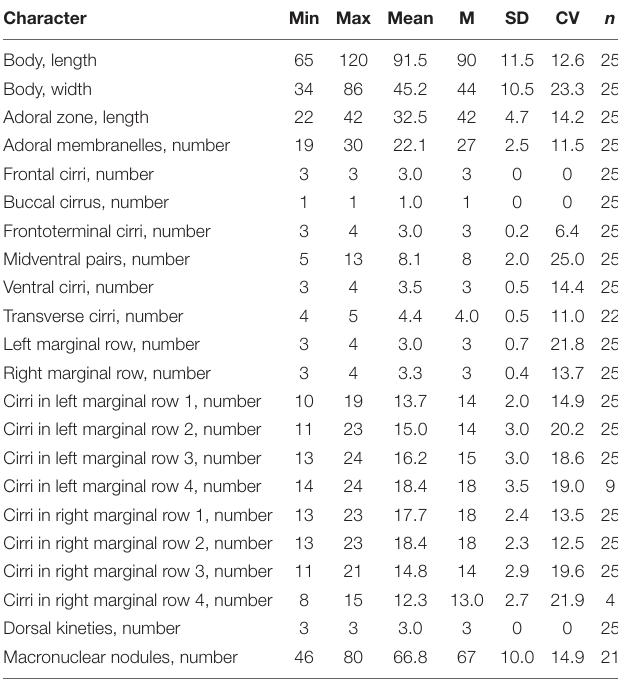
TABLE 1 | Morphometric characterization of Metaurostylopsis alrasheidi n. sp. based on protargol-stained specimens (measurements in µ m). Character Min Max Mean M